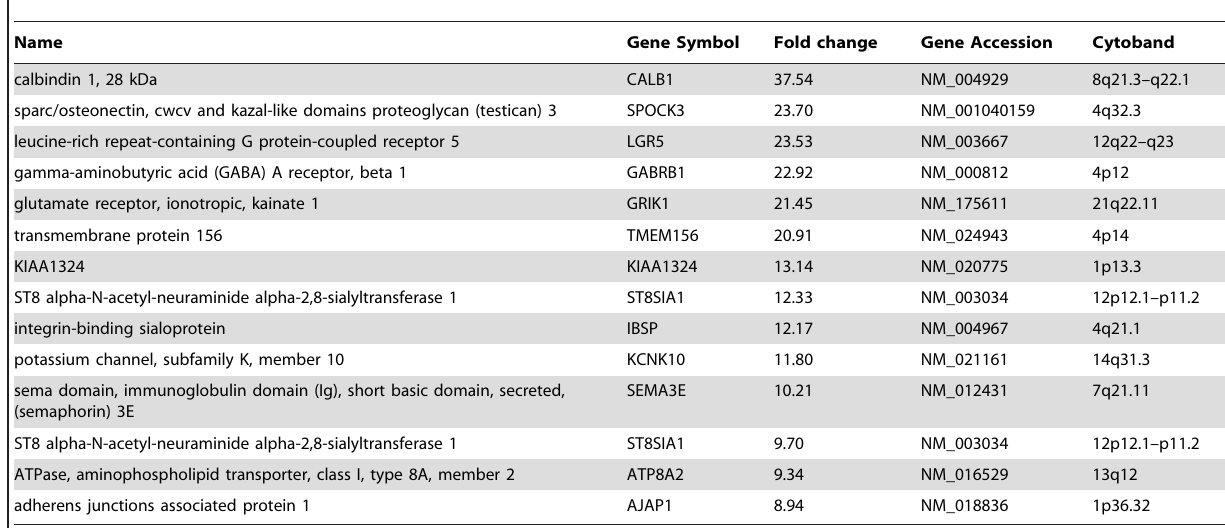
Table 2. Most up-regulated genes in the pulp tissue of permanent teeth as compared to deciduous